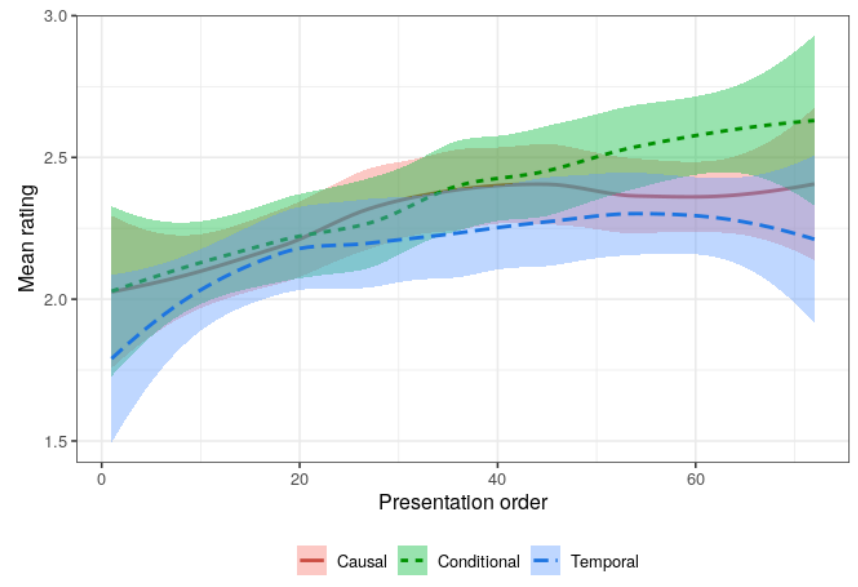
Figure 2. Effect of repeated exposure in Clausal Adjuncts in Chaves and Putnam (2021, p.